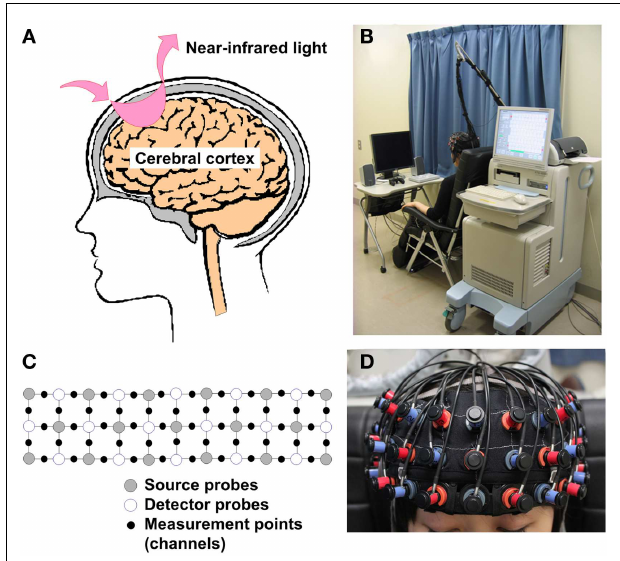
FIGURE 1 |Theoretical background and measurement settings of fNIRS . (A) Illustration of a simple source and detector probe set.When near-infrared light is emitted from a source probe onto the human scalp, it passes and scatters through brain tissues with relatively low absorption. Subsequently, part of this light is absorbed by blood hemoglobin in small vessels. A detector probe, normally placed 3cm away from the source probe in adults, can detect scattered near-infrared light reflected by the surface of the cortex. (B) fNIRS measurement setting (ETG-4000, Hitachi Medical Corporation). Commercial fNIRS machines are small, movable, and work silently, so that they are easy to use in clinical settings. (C,D) 3 × 11 Probe attachment and fitting condition. Multi-channel fNIRS machines use multiple sources and detector probes and are able to measure brain